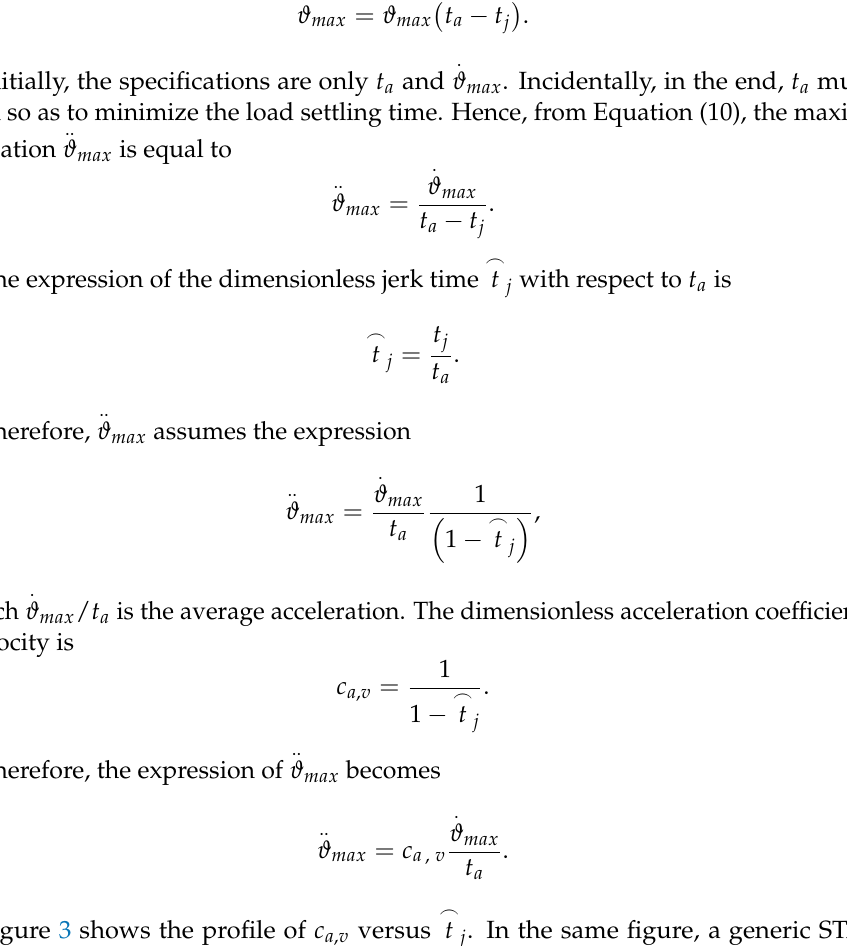
Figure 3. Profile of